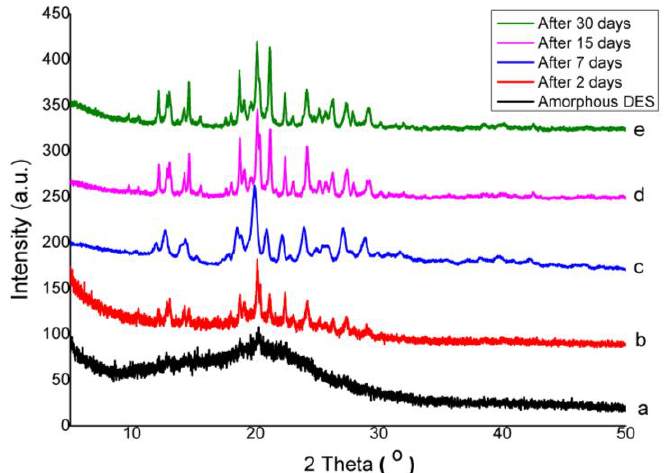
Figure 6. PXRD patterns of pure amorphous desloratadine (DES) for stability studies after storing at 40 °C under 75% RH and measured after specified periods of time: fresh prepared ( a ), 2 days ( b ), 7 days ( c ), 15 days ( d ), and 30 days ( e ).